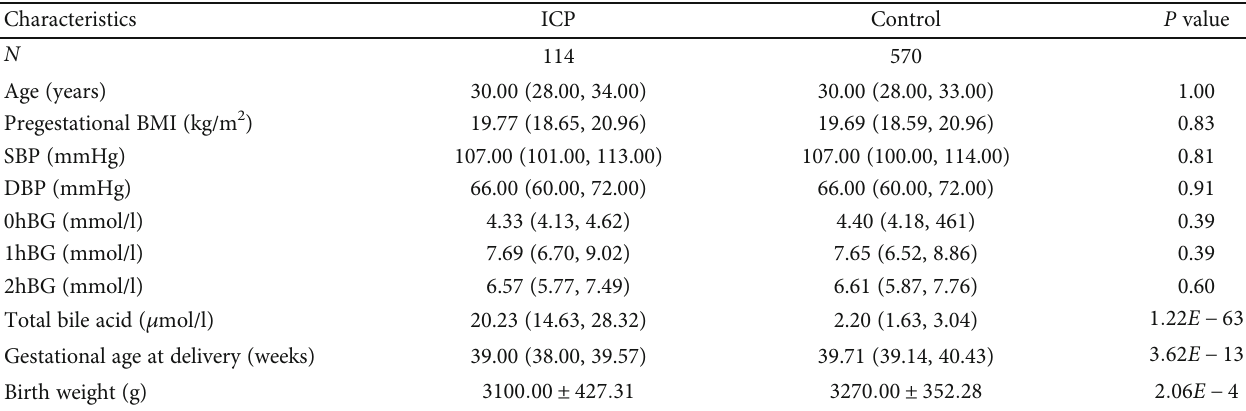
Figure 1: Flowchart of the study. ICP — patients with bileacids > 10 μ mol/l , UDCA — patients with ICP who received UDCA, and non- UDCA — patients with ICP who did not use UDCA. ICP: intrahepatic cholestasis of pregnancy; UDCA: ursodeoxycholic acid. Table 1: Characteristics of ICP and control